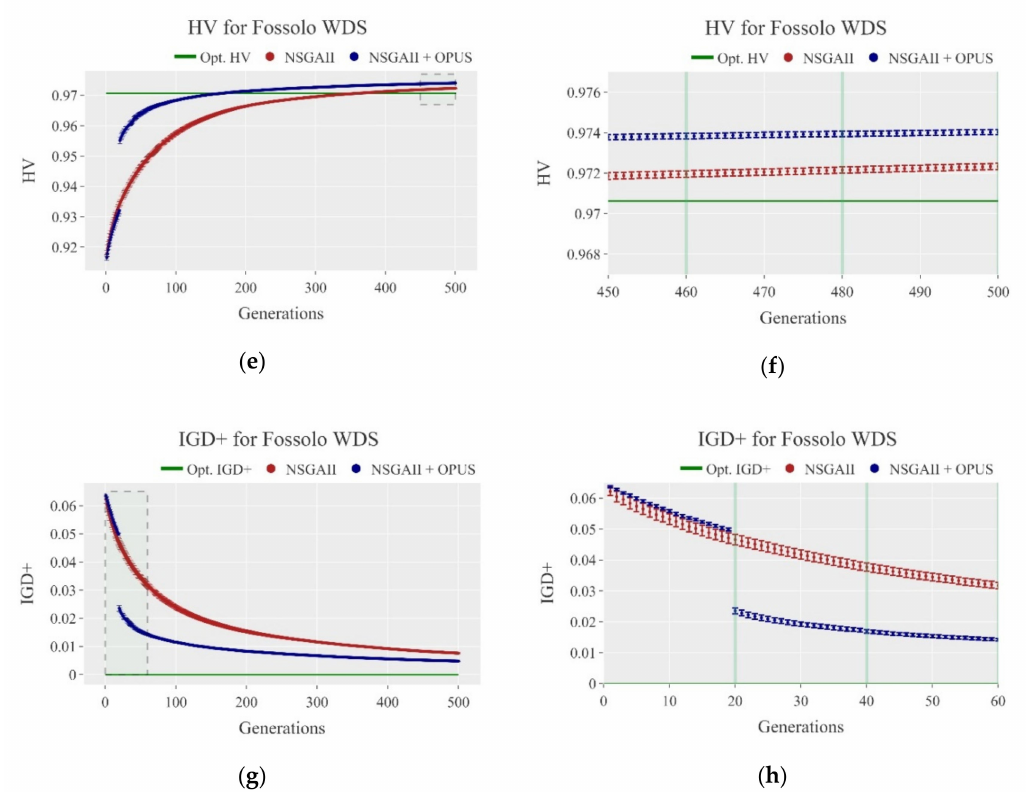
Figure 9. The 95% confidence intervals for performance metrics at each generation for multiple executions of the NSGA-II and the OPUS retrofitted algorithms. ( a ) HV for Hanoi; ( b ) stabilized HV for Hanoi; ( c ) IGD + for Hanoi; ( d ) IGD + for Hanoi during the first generations; ( e ) HV for Fossolo; ( f ) stabilized HV for Fossolo; ( g ) IGD + for Fossolo; and ( h ) IGD + for Fossolo during the first generations. The graphs at the right are the zoom of the dashed boxes of the graphs on the left. The green vertical lines indicate the generations in which OPUS was